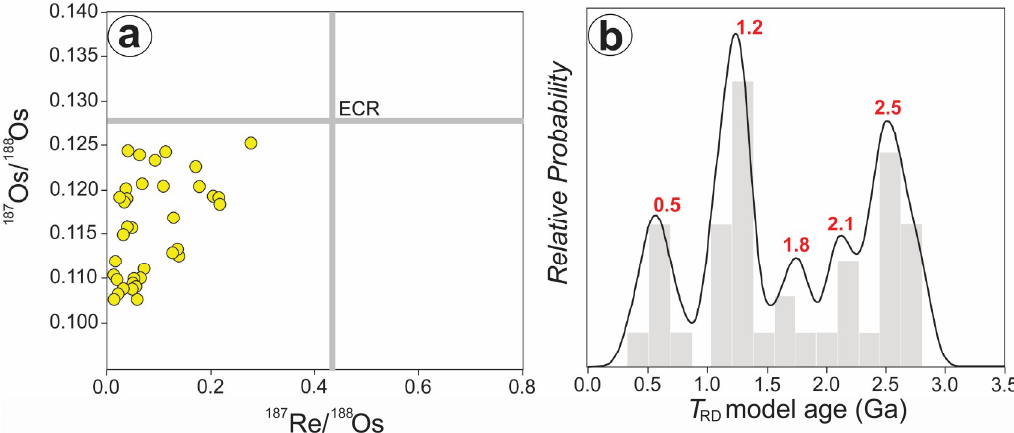
Figure 8. Re-Os isotope systematics in the analyzed pentlandite (n = 37 grains) of the North Andaman lherolites hosting the chromitites in terms of: ( a ) Isotopic ratios 187 Re / 188 Os and 187 Os / 188 Os; ( b ) Cumulative-probability plots and histograms (shaded bars, relative probability) of Os model ages (Ga) where uncertainties artificially were increased to 0.1 Ga to allow for uncertainty in the ECR model-age reference curve. This plot is most appropriate for estimates of the absolute depletion ages of different mantle domains, and for comparison between datasets from BMS and PGM.